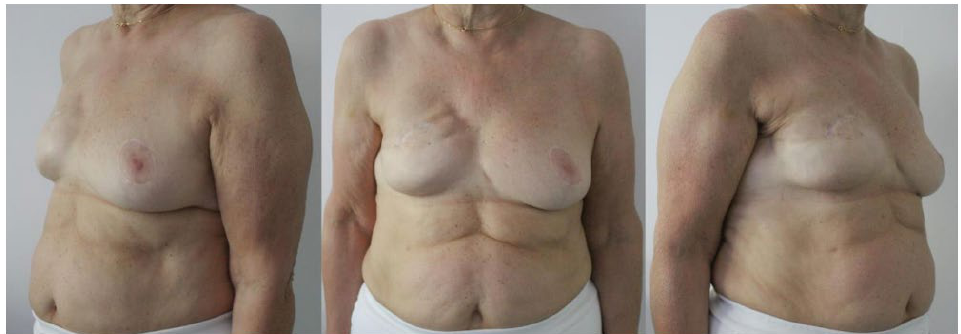
Figure 2. Post-operative result of a 68-year-old patient at 18-month follow-up. The right breast was reconstructed using a 320 cc anatomical implant. A contralateral reduction mammaplasty was performed in the same operative time. The aesthetic outcome reached scores of 7/10 and 6/10, according to patient and surgeon, respectively. The patient refused a fat grafting procedure to correct the medial rippling.